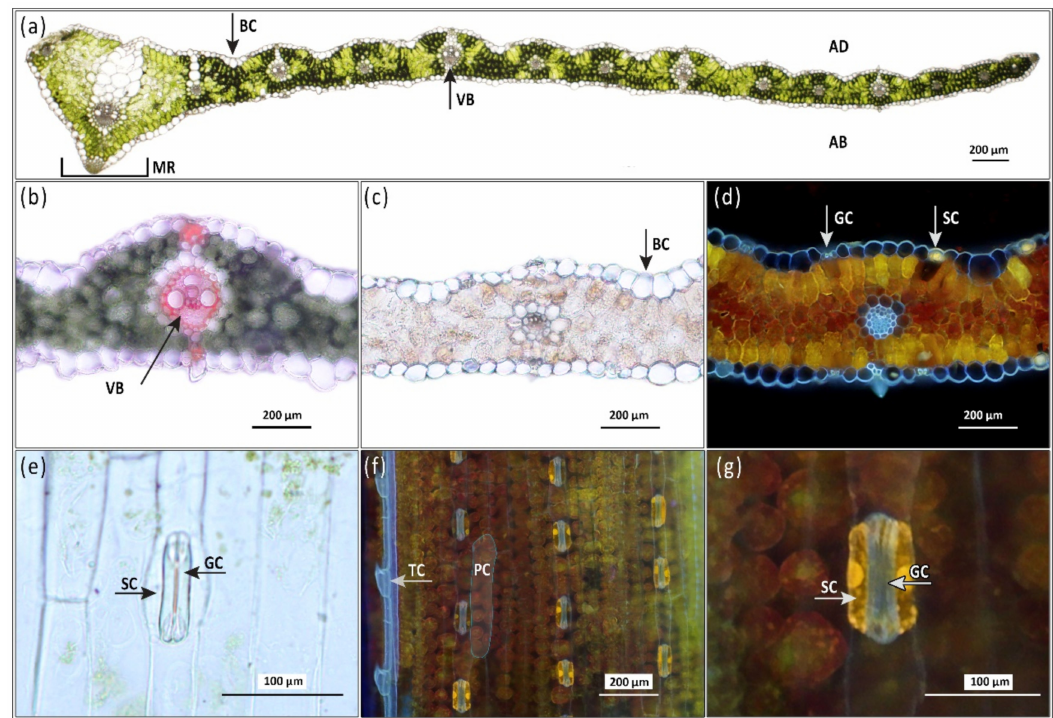
Figure 2. Examples of histochemical analyses of barley ( Hordeum vulgare) leaves. ( a ) Partial barley leaf cross section from one half of the lamina including midrib (MR) on left, bulliform cells (BC) of the abaxial epidermis, adaxial side (AD), and abaxial side (AB). Fresh hand section not treated histochemically, imaged at 40 × magnification, bright field. ( b ) Phloroglucinol-HCl test for lignins (pink-red color) in vascular bundle (VB) and sclerenchymatous extensions of bundle sheath leading to epidermal cells, 100 × , bright field. ( c ) Vanillin HCl test for condensed tannins (bright red) not detected in mesophyll, 100 × , bright field. ( d ) Naturstoff reagent A test (yellow fluorescence) for flavonoids, detected in the mesophyll but absent in the epidermis except for stomatal subsidiary cells, arrows point to stomatal guard cells (GC) and subsidiary cells (SC), 100 × , UV fluorescence. ( e ) Barley stomata from an epidermal peel showing guard cells (GC) and subsidiary cells (SC), 200 × , bright field. ( f ) The paradermal view on a segment of a barley leaf treated with Naturstoff reagent A showing vacuolar flavonoids (yellow fluorescence). Leaf segments were of 1 mm 2 size so the reagent could penetrate the intact epidermal cells via mesophyll cells. Flavonoids are present only in SC and GC and in the mesophyll cells below the transparent epidermal pavement cells. Trichome cells (TC) along leaf vein show blue autofluorescence and pavement cells (PC) (highlighted to indicate size and position) lack fluorescence except a faint blue color along cell walls, 100 × , UV fluorescence. ( g ) Zoomed in view of stomatal guard cells (GC) and subsidiary cells (SC) treated with Naturstoff reagent A showing intracellular fluorescence of phenolic compounds. Adjacent epidermal pavement cells do not show flavonoid fluorescence and their transparency enables the viewing of flavonoid fluorescence in the mesophyll layer below, 100 × , UV